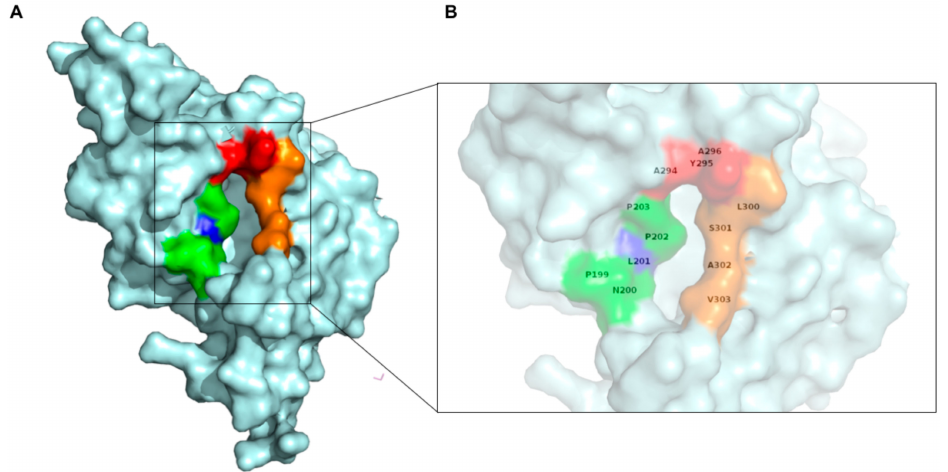
Figure 9. mVP40 Leu 201 residue may be part of a hydrophobic pocket that can interact with a host factor. ( A ) mVP40 monomer highlighting Leu 201 (in blue) and neighboring residues forming a hydrophobic pocket. (in green residues 199–203, in red residues 294–296, and in orange residues 300–303) ( B ) A zoomed image of the hydrophobic pocket that includes Leu 201 .